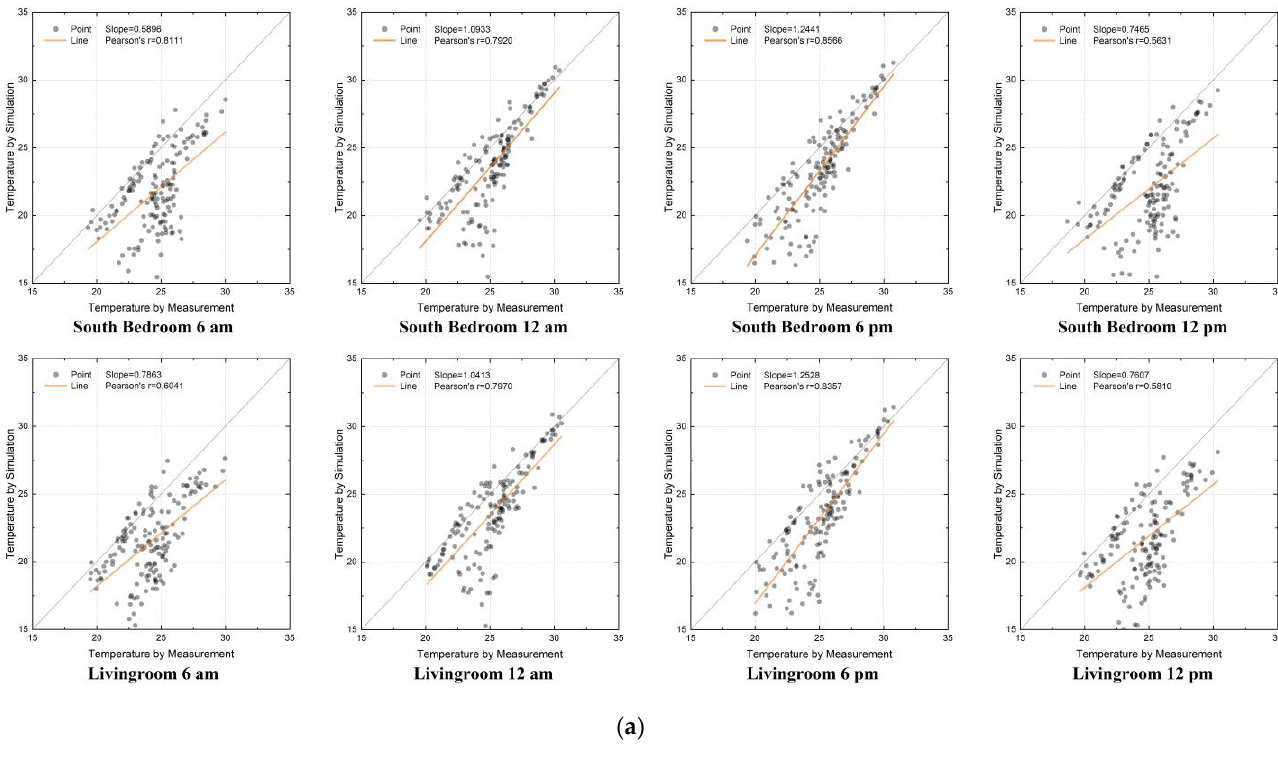
Table 14. Building energy consumption composition in five cities.